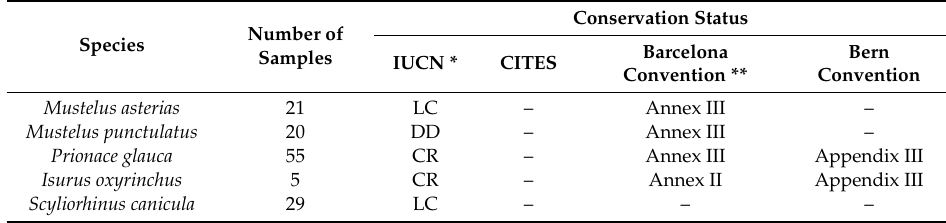
Table 4. Conservation status of identified